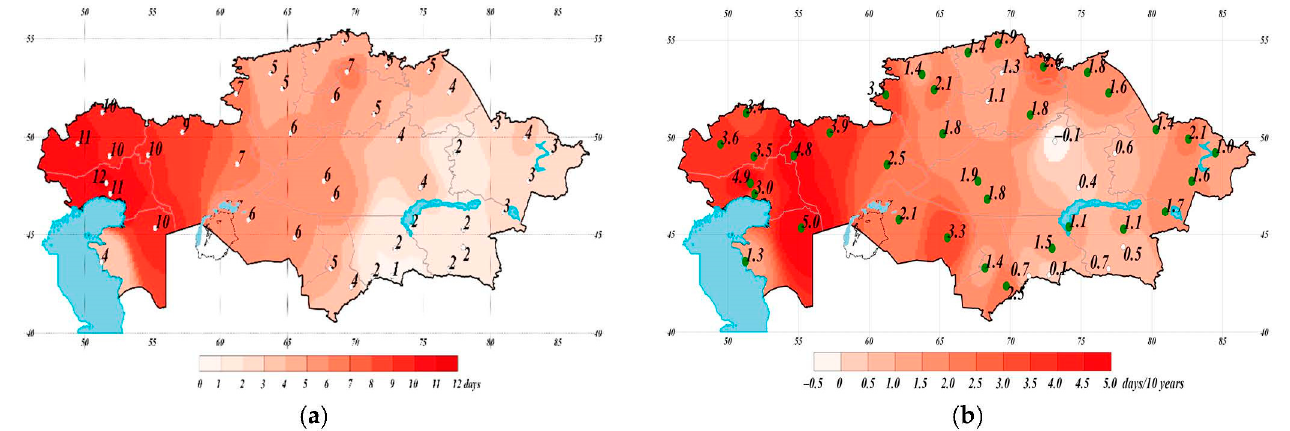
Figure 8. The spatial distribution of the index characterizing the distribution of the duration of heat waves (WSDI) ( a ) and trends ( b ) of this parameter for the period 1971–2020. The heat wave duration index (WSDI) increased from the east of the center to the west of Kazakhstan. In the east of the republic, the value of the duration of the heat wave was 4–5 days. In the center of the republic from south to north, there is also an increase in the spread of days with waves of heat. In the southeast of Kazakhstan, the days with heat waves amounted to 2–5 days.